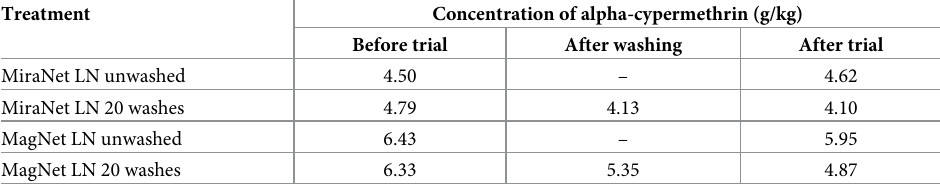
Table 2. Chemical analysis of alpha-cypermethrin on LNs in the experimental hut trial in M’be´.